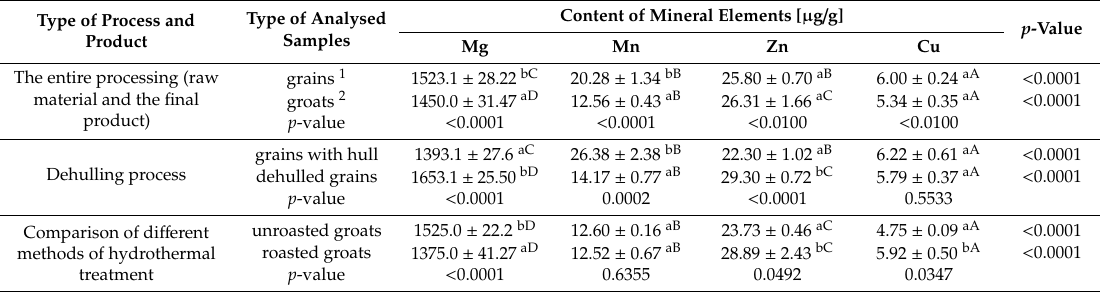
Table 1. The content of selected minerals in analysed samples depending on the technological process (mean ± SD; values in µ g /